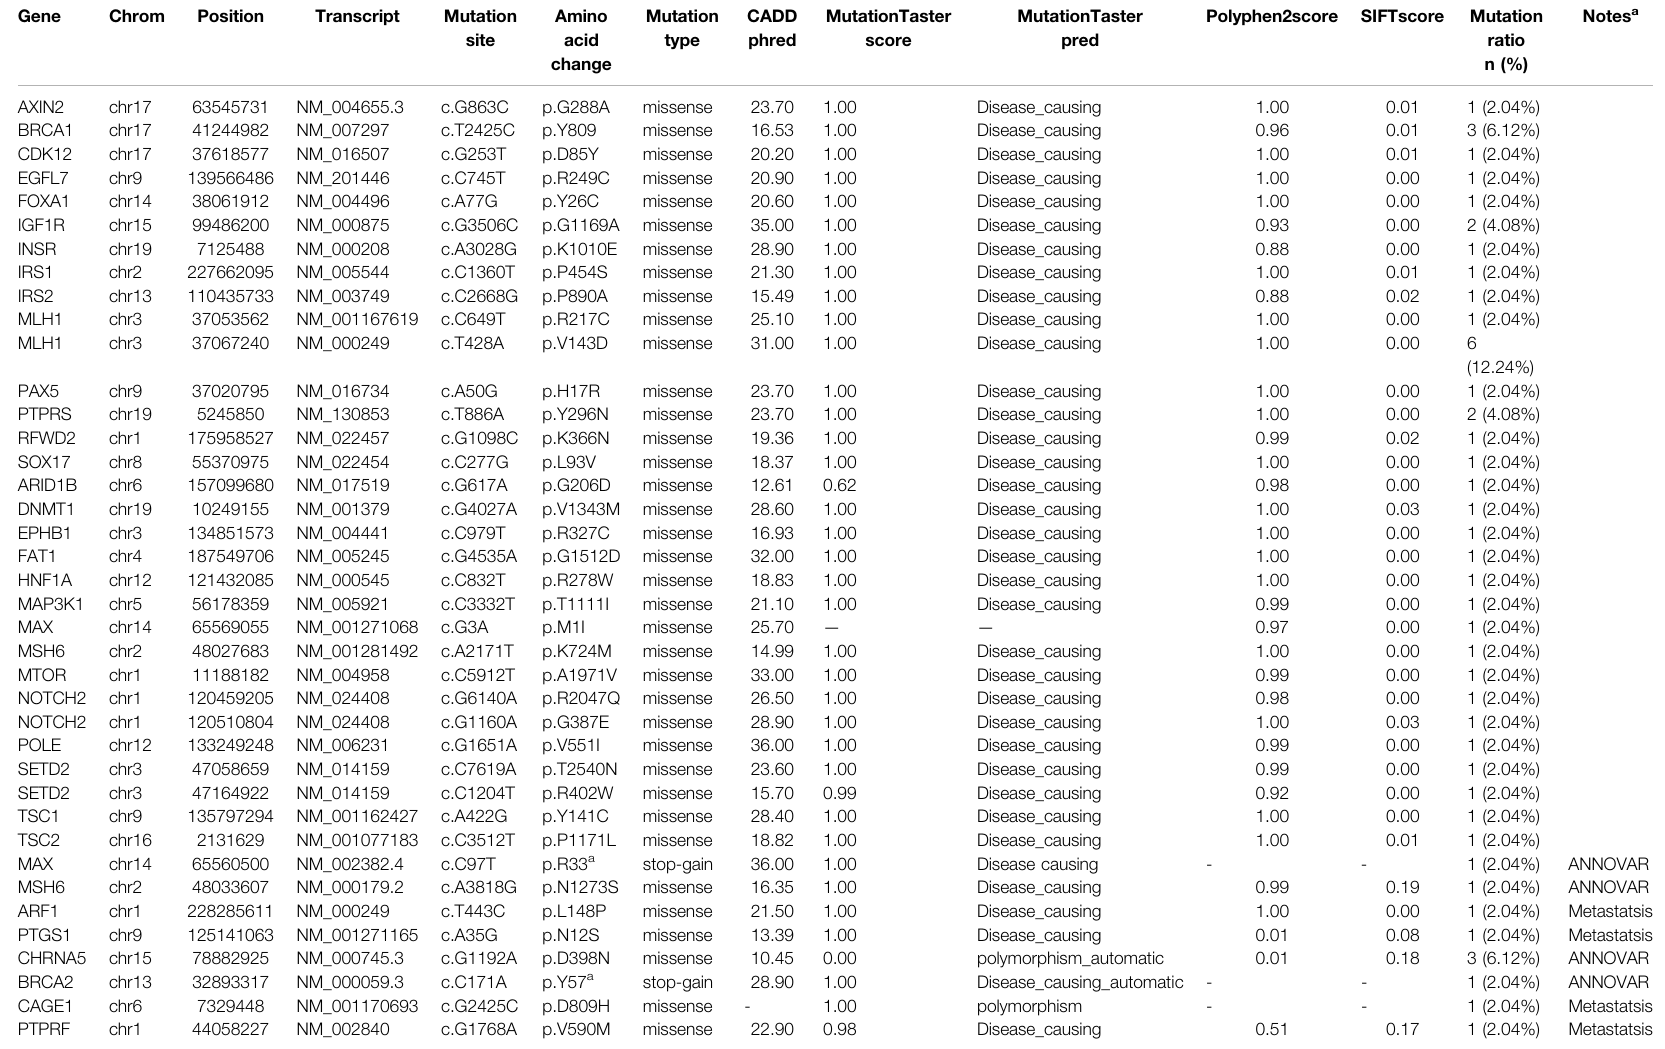
TABLE 3 | Potential tumor-related mutations identi fi ed in GIST.